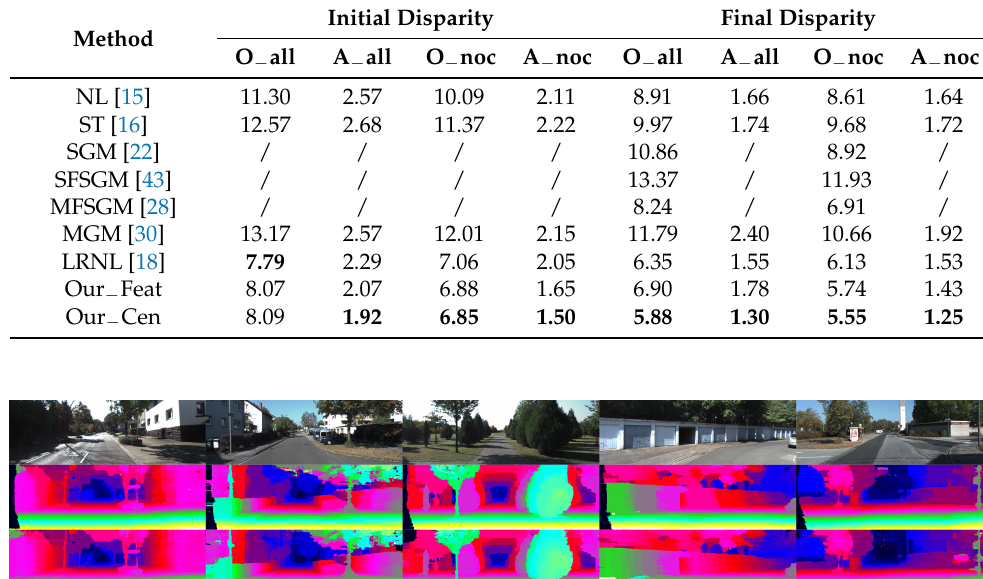
Table 5. Comparison of typical cost aggregation methods on KITTI 2015 dataset [38].